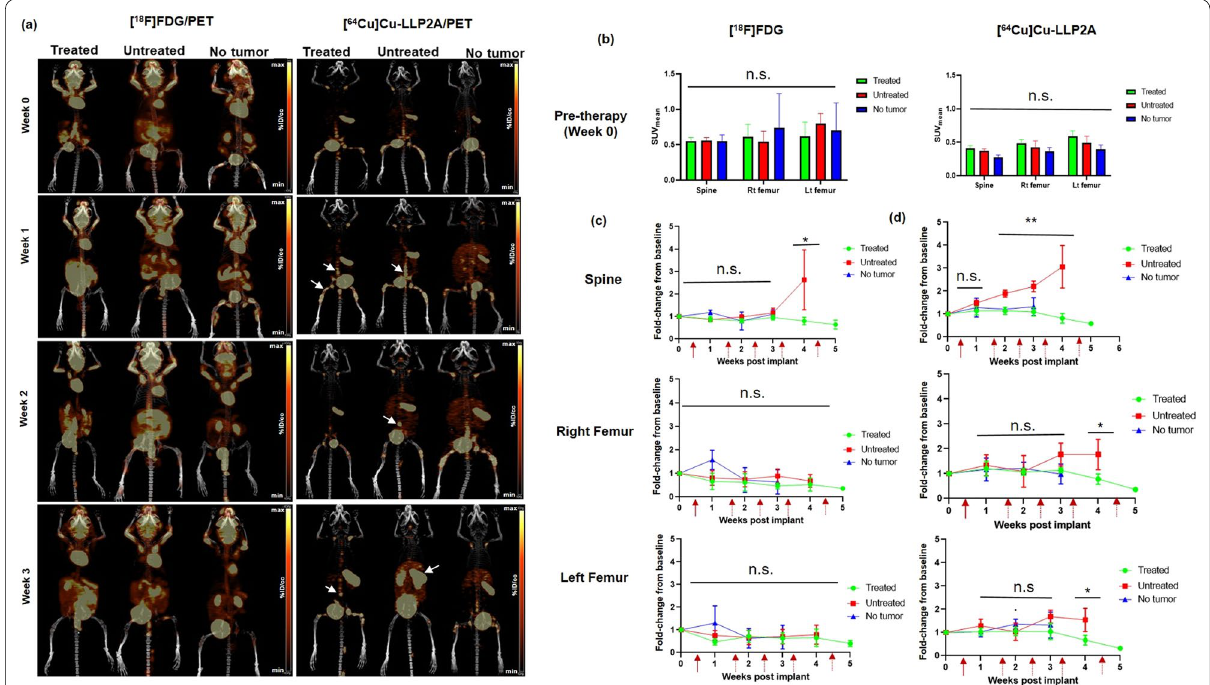
Fig. 3 a Representative small animal maximum intensity projection (MIP) [ 18 F]FDG and [ 64 Cu]Cu-LLP2A PET images in disseminated MM.1S-CG tumor mice (treated and untreated) as well as in no tumor mouse cohorts, respectively. Bortezomib therapy was started in the treatment cohort between weeks 0–1. White arrows are pointing to the selected focal tumor lesions in the treated and untreated mice imaged with [ 64 Cu]Cu-LLP2A/ PET. Scale Bar ([ 18 F]FDG): Min 4% ID/cc, Max 8% ID/cc; Scale Bar ([ 64 Cu]Cu-LLP2A): Min 3% ID/cc, Max 6% ID/cc. b [ 18 F]FDG and [ 64 Cu]Cu-LLP2A PET quantification (SUV mean ) of the bone marrow rich organs – spine, right (Rt) femur and left (Lt) femur, in MM.1S-CG disseminated tumor model and no tumor mice at week 0 (baseline, before therapy was started). c [ 18 F]FDG SUV fold-change from baseline in the spine, right (Rt) femur and left (Lt) femur in MM.1S-CG tumor (treated and untreated) mice and no tumor mice, plotted as a function of time. d [ 64 Cu]Cu-LLP2A SUV fold-change from baseline in the spine, right (Rt) femur and left (Lt) femur in MM.1S-CG tumor mice (treated and untreated) and non-tumor mice, plotted as a function of time. * p 0.05, ** p ≤ ≤